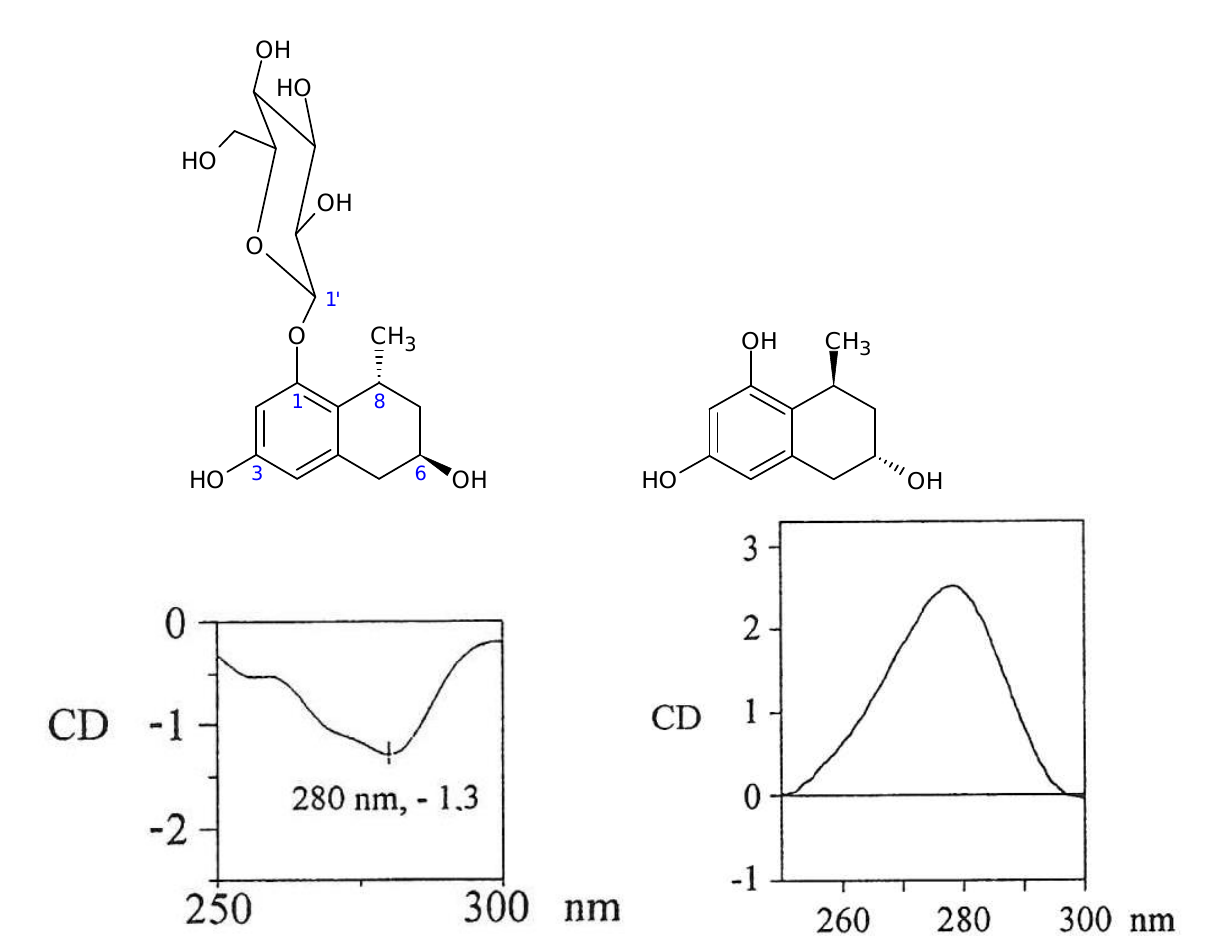
Figure 7. ( A ) ESI-MS of 9 ; ( B ) 1 H- (left) and 13 C-NMR spectra (right) of 9 ; ( C ) excerpts from its HMBC spectrum; ( D ) couplings in 9 as presented in the HMBC spectrum.